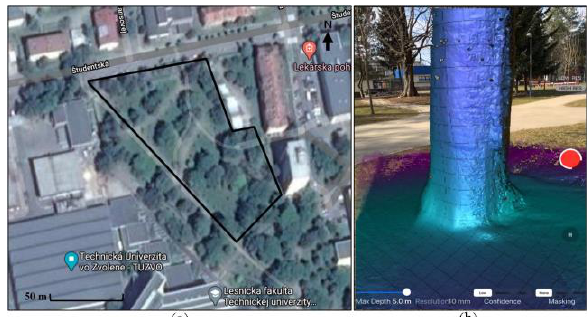
Figure 1. Urban park in Zvolen. (a) Plot area; (b) example of single-tree mode with 10 mm resolution at Low